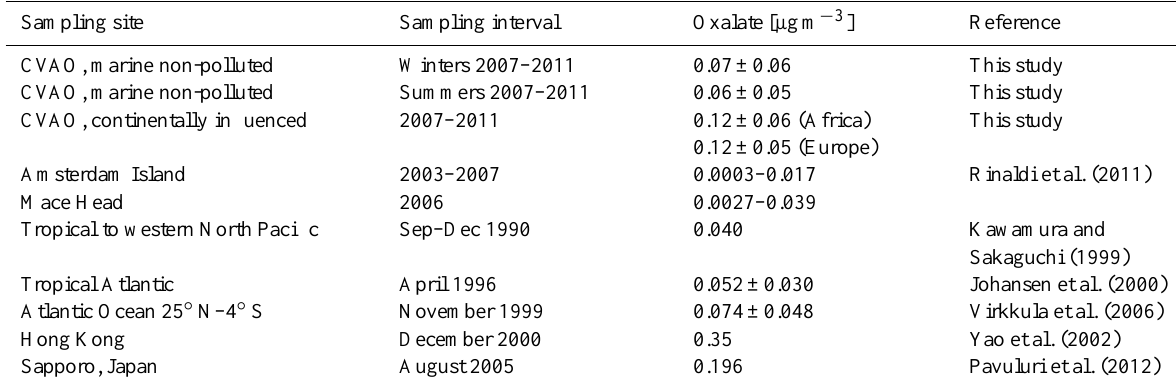
Table 4. Comparison of published averaged oxalate concentration in PM 10 aerosols with the results of this study. Sampling site Sampling